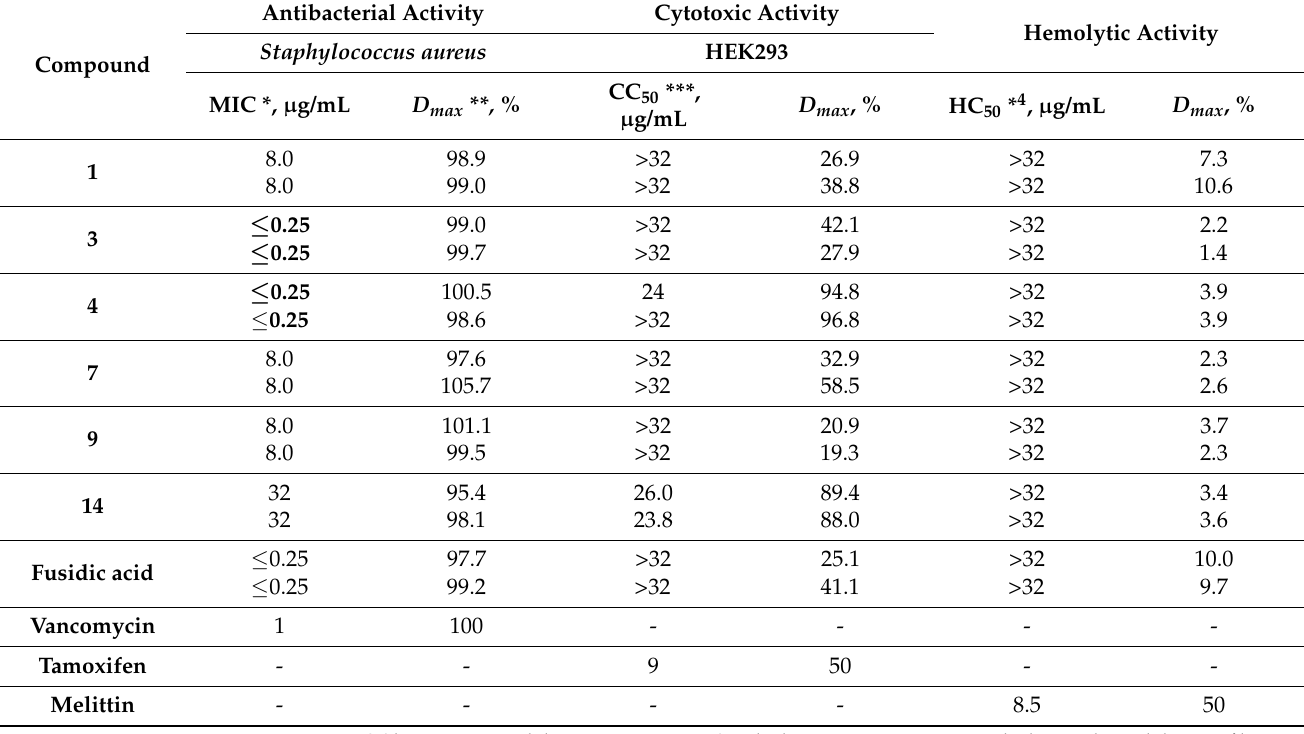
Table 1. Antibacterial, cytotoxic, and hemolytic activity of compounds 1 , 3 , 4 , 7 , 9 , 14, and fusidic